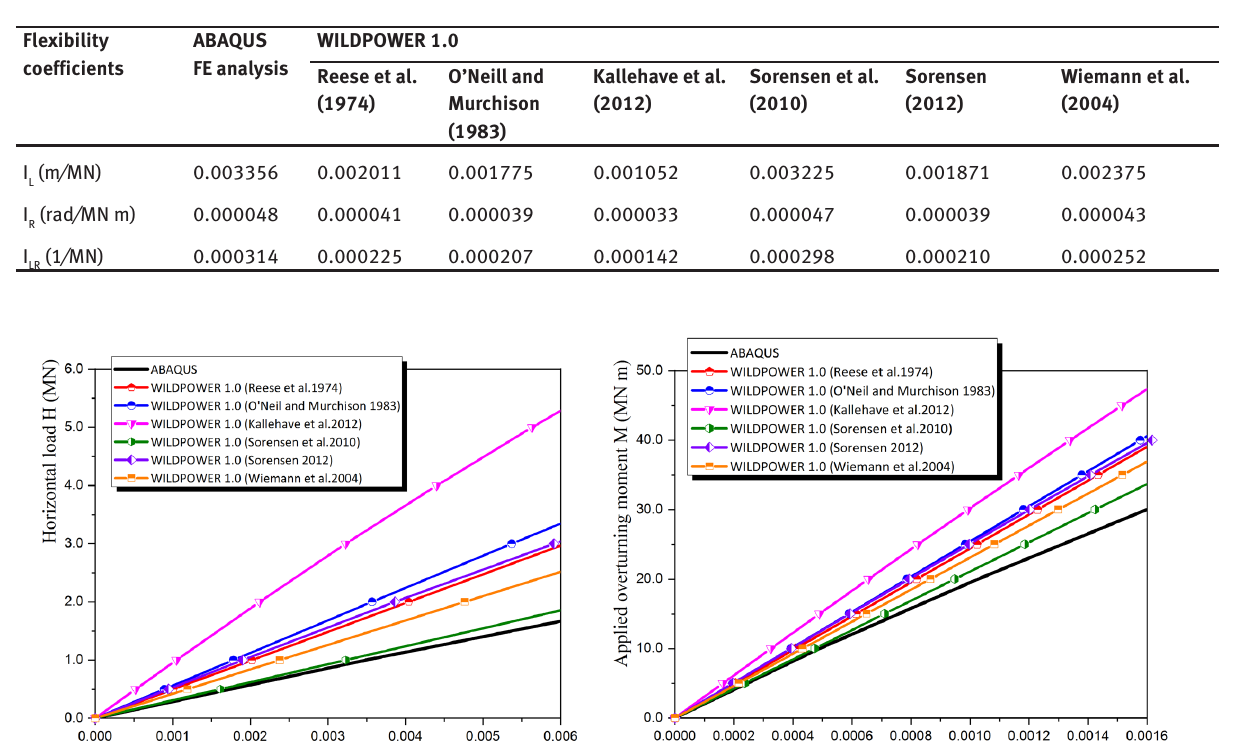
Table 6: Monopile head flexibility coefficients.